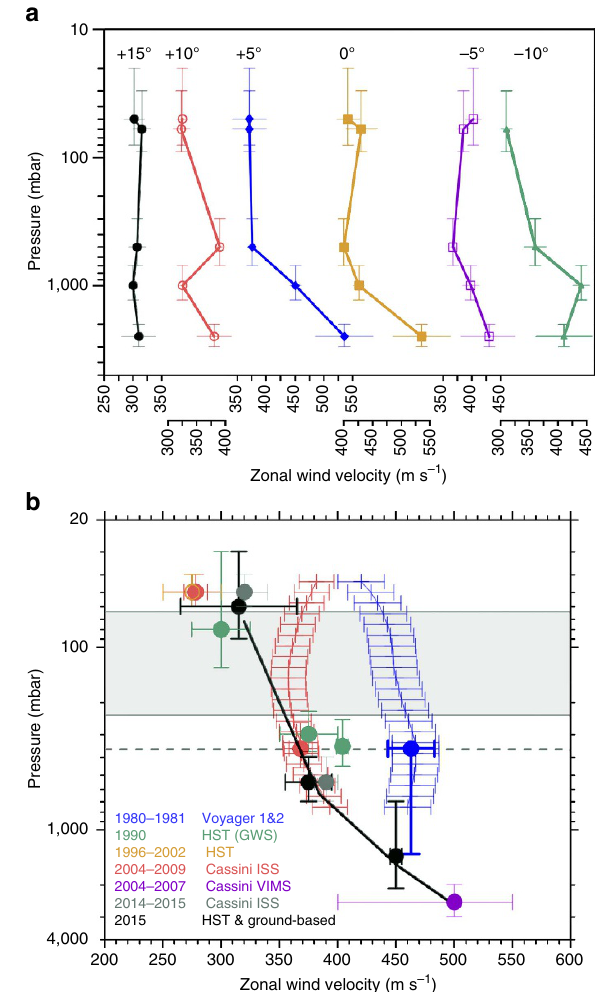
Figure 8 | Vertical structure and temporal variability of Saturn’s Equatorial winds. ( a ) Vertical profiles of the zonal wind retrieved in 2014–2015 at 6 planetographic latitudes: þ 15 (cid:2) (black), þ 10 (cid:2) (red), þ 5 (cid:2) (blue), 0 (cid:2) (brown), (cid:2) 5 (cid:2) (violet), (cid:2) 10 (cid:2) (green). Altitude (pressure level) retrievals correspond to the following wavelengths: 50 mbar (890nm, dots in Fig. 7a), 60 mbar (336nm, circles in Fig. 7a), B 500mbar (689-750–937nm, blue and violet lines in Fig. 7b), B 1.4bar (689–750–937nm, black line in Fig. 7b), B 2.5bar (dashed line in Fig. 7b; VIMS data from 18 ). The vertical (altitude) error bar is from the radiative transfer model (refer to Fig. 6). The horizontal (velocity) error bar is from Fig. 7 profiles (one s.d. from the mean, Methods section); ( b ) Vertical profiles of the zonal wind (planetographic latitudes þ 4 (cid:2) to þ 8 (cid:2) ) between 1980 and 2015. Dots are for cloud tracers in 2014–2015 (gray from Cassini ISS and black from HST and ground-based images) and for 1980–2009 (blue from Voyager 1 and 2, green and orange from HST, red and magenta from Cassini ISS) 7–10,12,19,20,32,39 . The black line shows the vertical shear of the zonal wind for 2014-15 extended downwards to the 2004–2007 from Cassini VIMS data. Colour lines show temporal variability in thermal winds retrieved in 1980–81 (blue) and 2004–2009 (red). They use as reference the wind velocity at 360 mbar (red and blue points for 2004–2009 and 1980–1981 on the dashed horizontal line) 13,43 . The shaded area indicates the location of the equatorial tropopause 44 . The vertical (altitude) error bar is from the radiative transfer model (refer to Fig. 6). The horizontal (velocity) error bar for cloud tracers (dots) is from Fig. 7 profiles (one s.d. from the mean wind profile, Methods section) and for thermal winds (red and blue lines) is one standard deviation from the mean in the þ 4 (cid:2) to þ 8 (cid:2) latitude band that include a variety of error sources as discussed in ref.